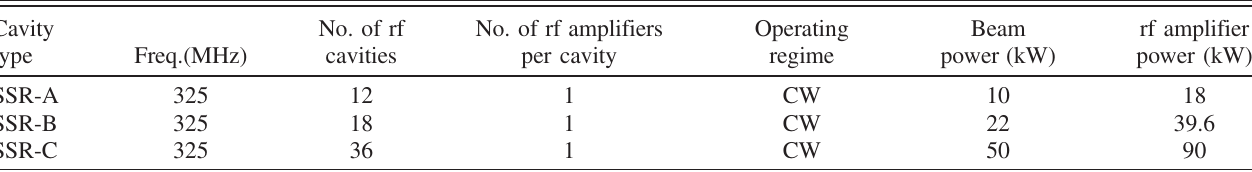
TABLE IX. MEHIPA high power rf requirements.